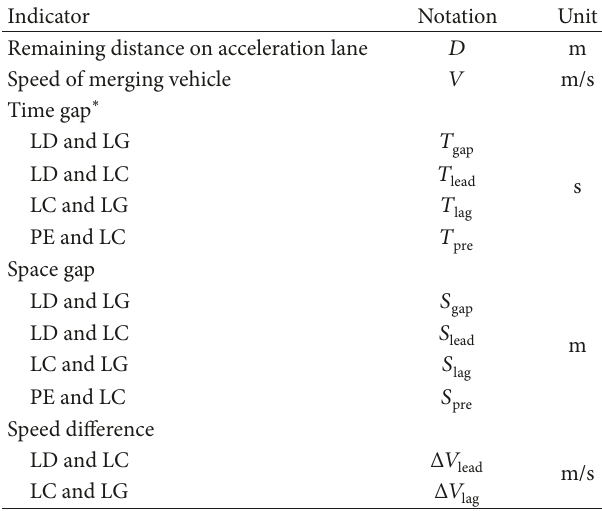
Table 1: Potential variables in the merging